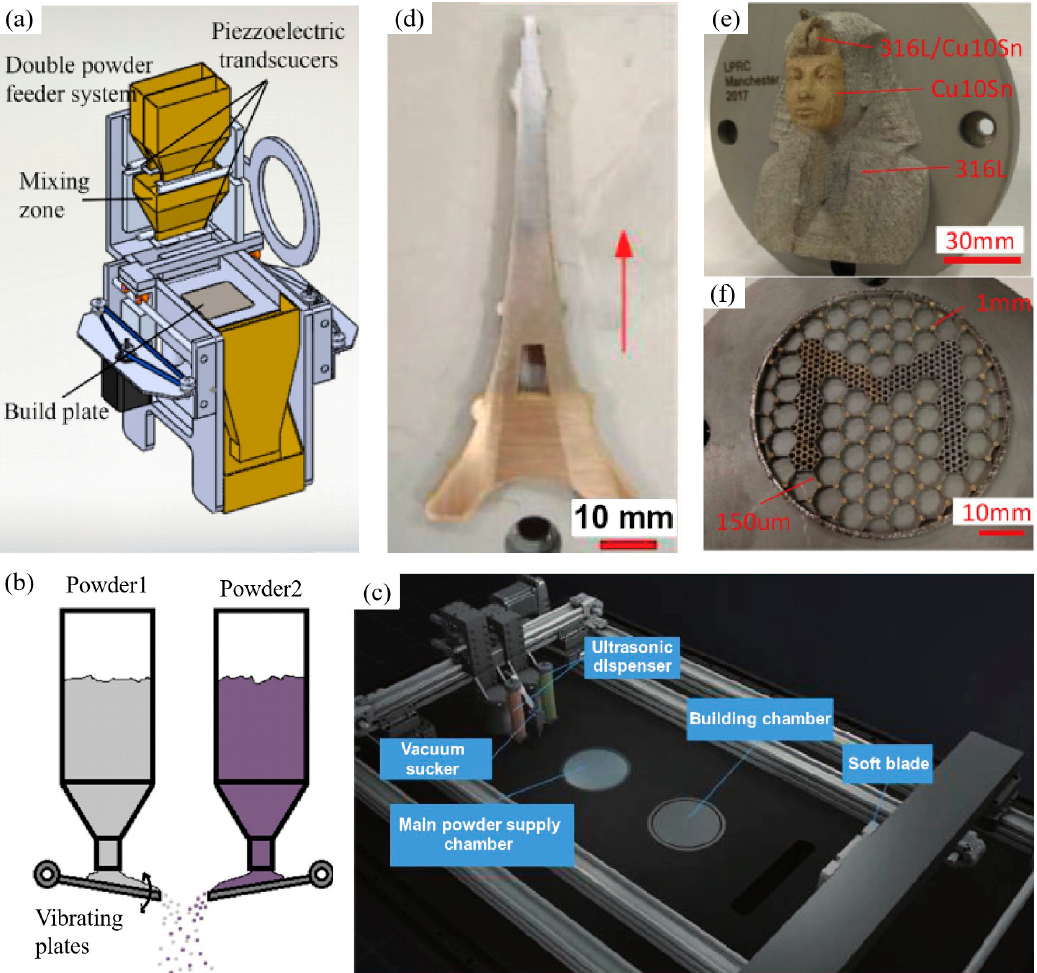
Figure 3. Powder feeder system: ( a ) Prototype schematic diagram; ( b ) Working principle for mixing powders [95]; ( c ) LPBF experimental setup with an ultrasonic powder delivery system; ( d – f ) Cu10Sn/316L FGM components [88,97].